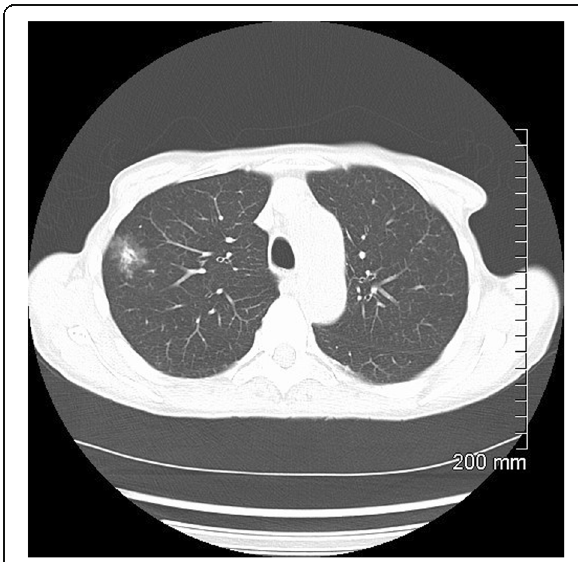
Fig. 12 Favourable prognostic indicators: ground glass component. The part-solid nodule in the right upper lobe has a large ground glass component which correlates with lepidic growth. AIS